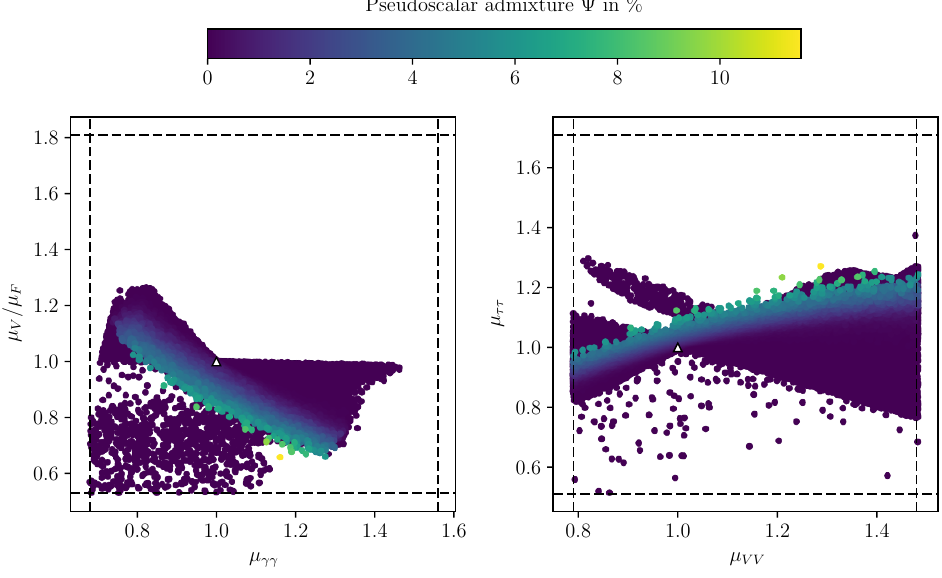
Figure 2 . C2HDM type II: pseudoscalar admixture (cid:9) C2HDM of h 125 as a function of the most constraining signal strengths. The dashed lines show the experimental limits and the white triangle denotes the SM